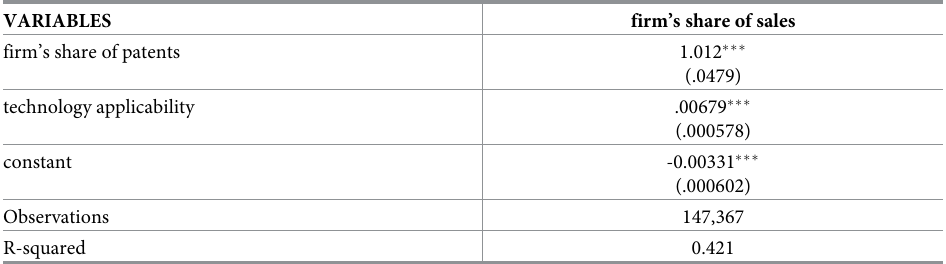
Table 4. Firm level market share of sales and